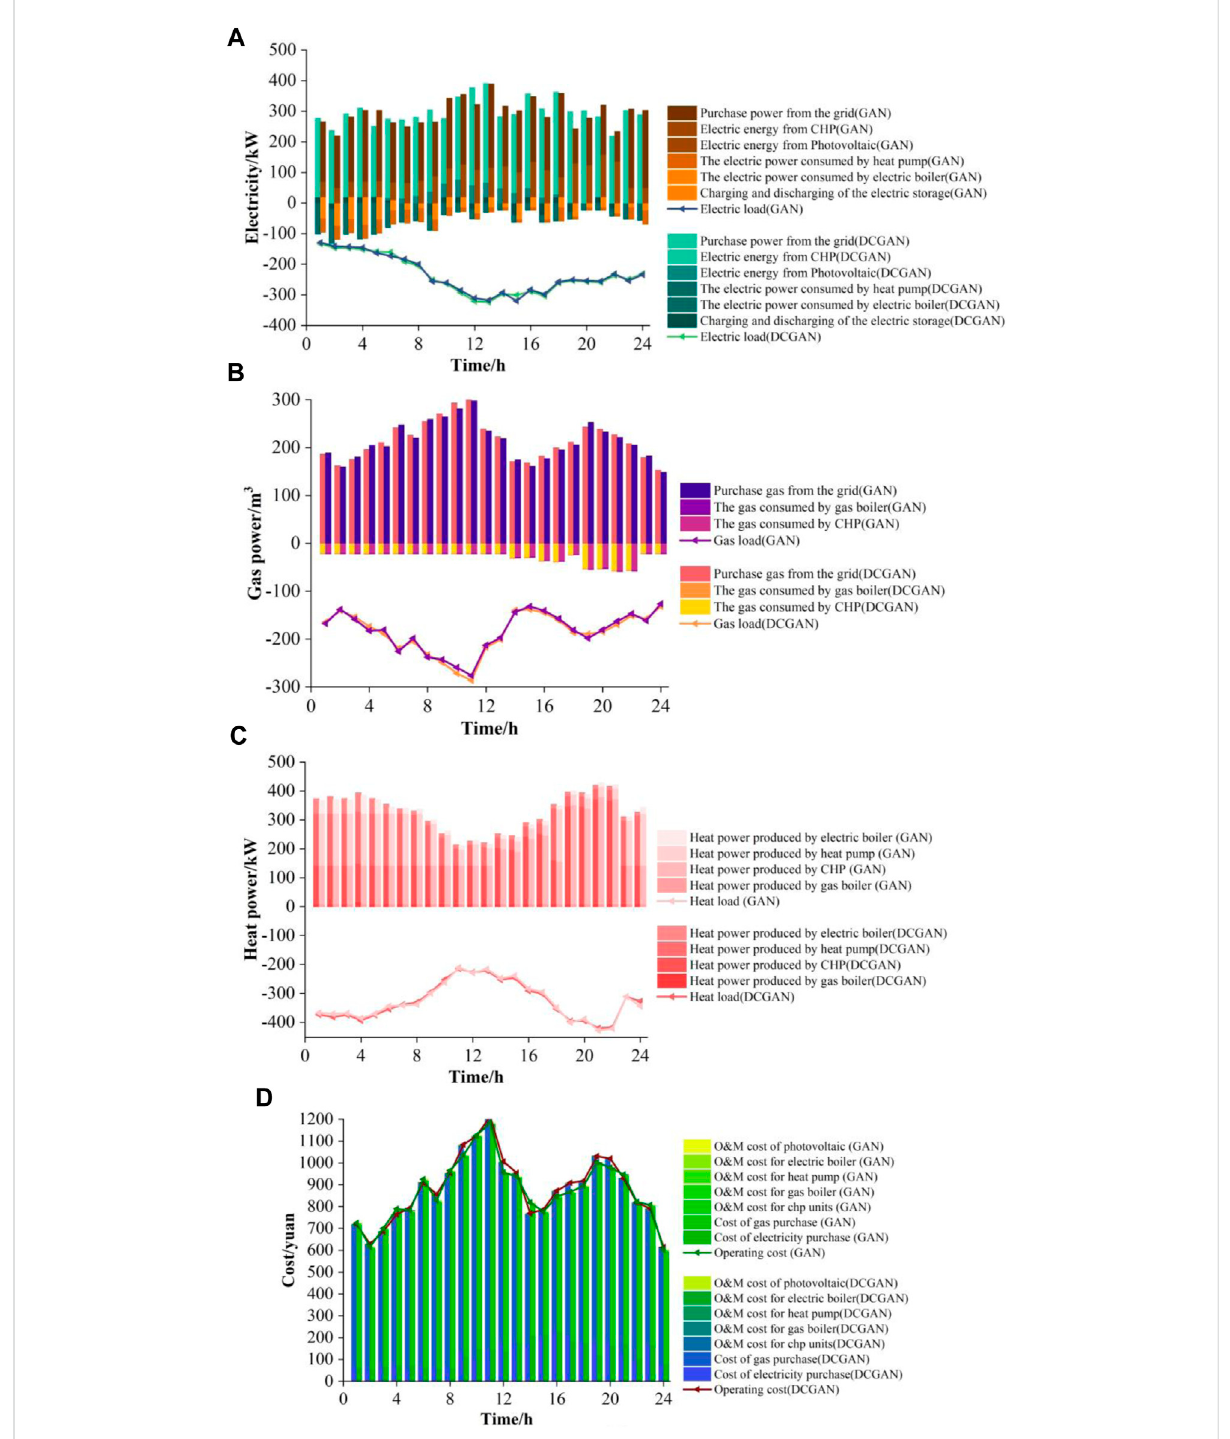
FIGURE 9 Comparisons of day-ahead scheduling results based on DCGAN scenario generation and GAN scenario generation: (A) electricity; (B) natural gas; (C) heat power; (D)